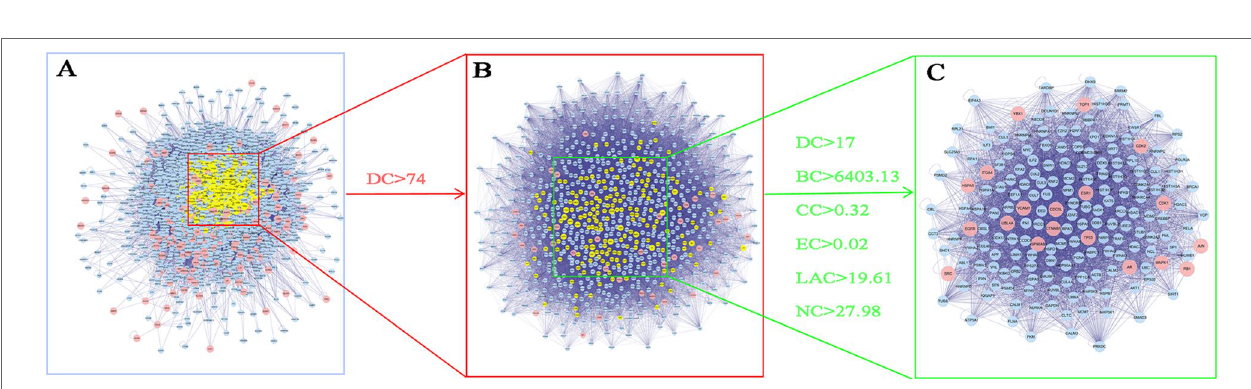
FIgUrE 3 | Identification of candidate targets of YQSX against ITP. (a) The interactive PPI network of YQSX putative targets and ITP-related targets. (B) PPI network of significant proteins extracted from A. (c) PPI network of candidate YQSX targets for ITP treatment extracted from B. DC, degree centrality; BC, betweenness centrality; CC, closeness centrality; EC, eigenvector centrality; LAC, local average connectivity-based method; NC, network centrality.